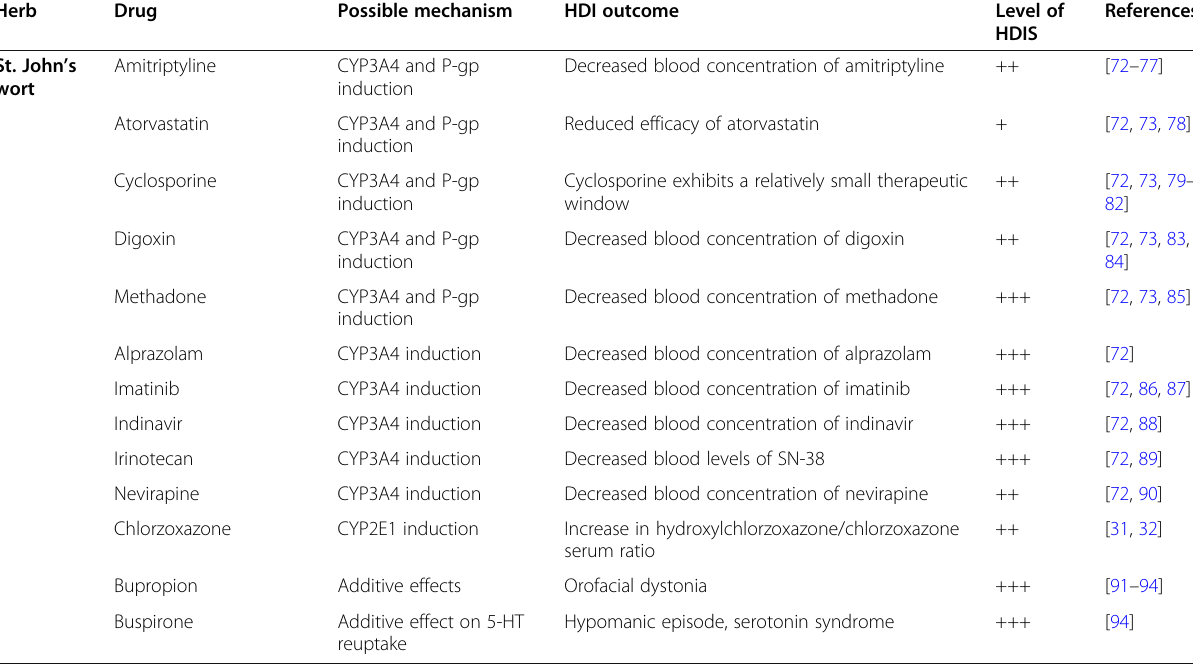
Table 1 Herb-drug interactions (HDIs) of some herbs with possible mechanism, outcome and level of HDIs (Continued) Herb